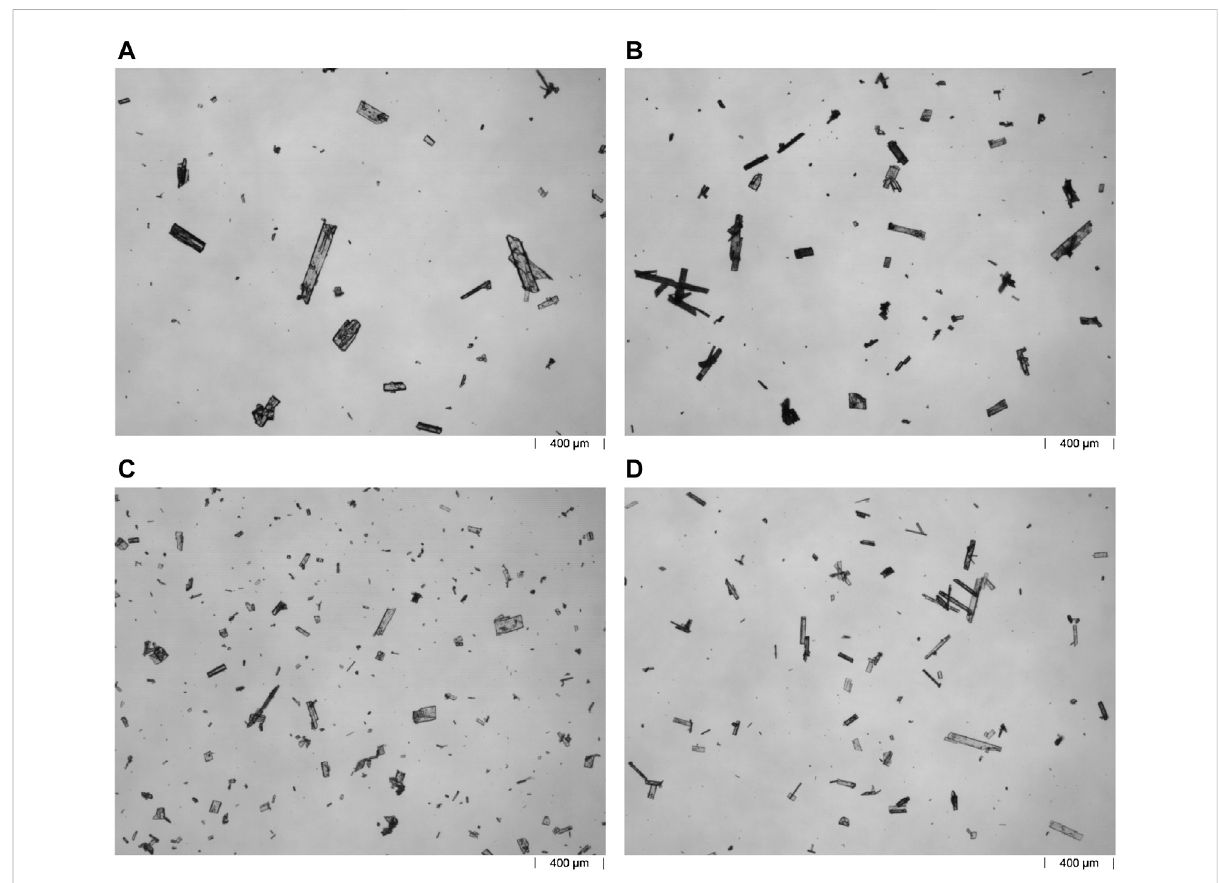
FIGURE 12 Representative microscope images of the crystals from experiments 5 – 8 are shown in (A – D) , respectively.